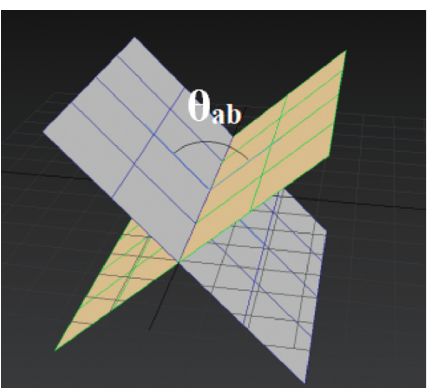
Figure 9: The dihedral